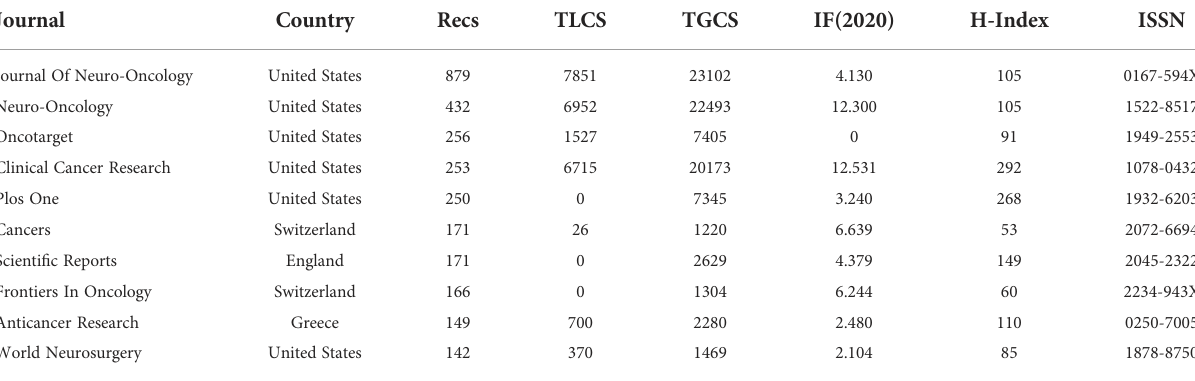
TABLE 3 The top 10 journals ranked by their Recs in the TMZ